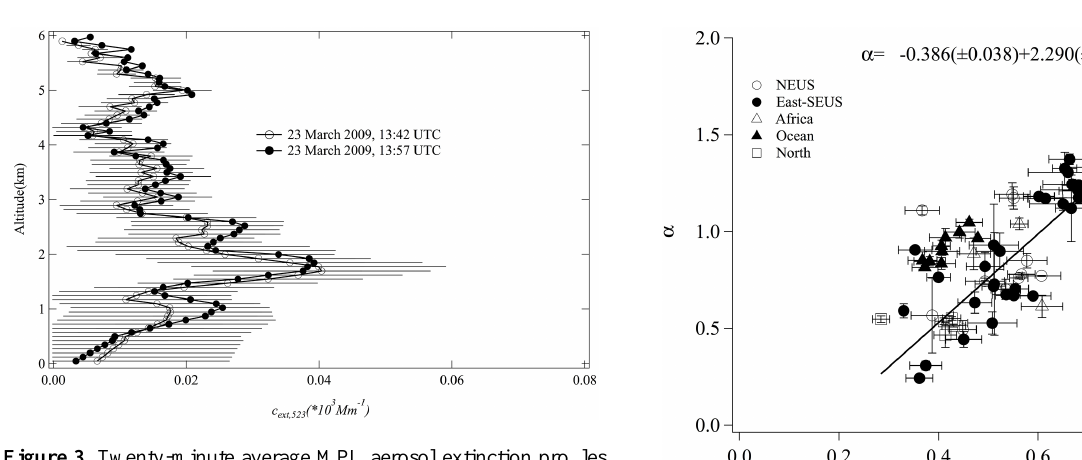
Figure 3. Twenty-minute average MPL aerosol extinction profiles at 527nm for two time periods on DOY 82. The error bars depict uncertainty of retrieval. τ 500 during this period was 0.11. The flow regime on this day was NEUS. Figure 4. Hourly averaged column α versus hourly averaged R sub-surf for near-surface aerosol. The line depicts a regression as described in Sect. 2.3.6, and r 2 = 0 . 49. Vertical and horizontal error bars depict standard deviations of the hourly averaged